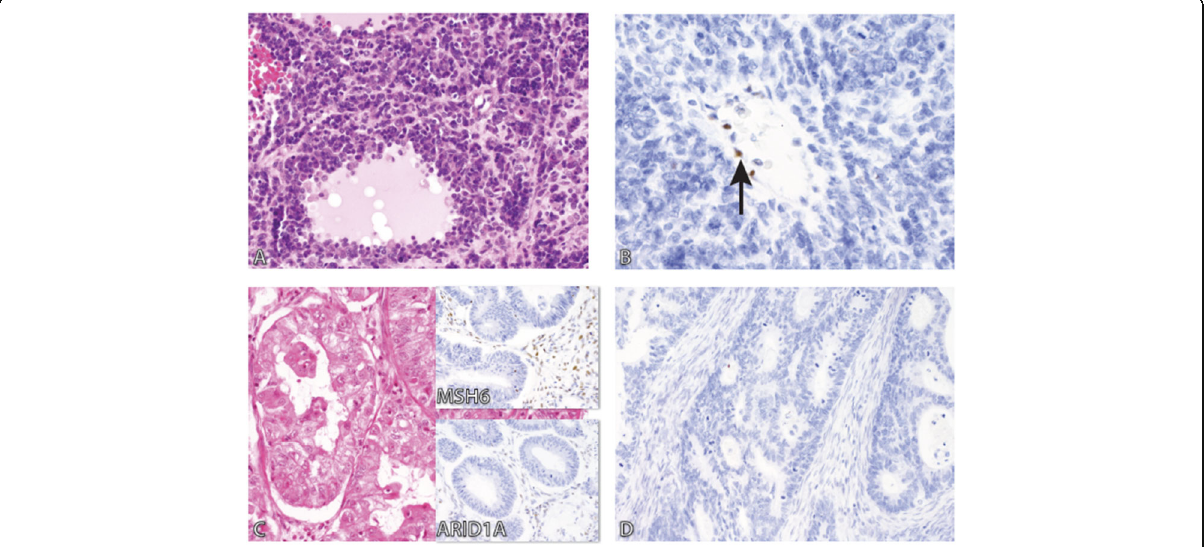
Fig. 3 A case of SCCOHT showing diffuse small cells with dark nuclei and pseudo follicles with eosinophilic material ( a ), and the loss of BRG1 staining in tumor cells ( b ) and positive staining of stroma cells (Arrow). c shows a case on EC with mucinous features (initially diagnosed as MC) with loss of MSH6 and ARID1A (insets) in tumor cells with positive staining in stromal tissue and lymphocytes. D is a case with Loss of ARID1A with no internal control (no staining of stromal tissue or